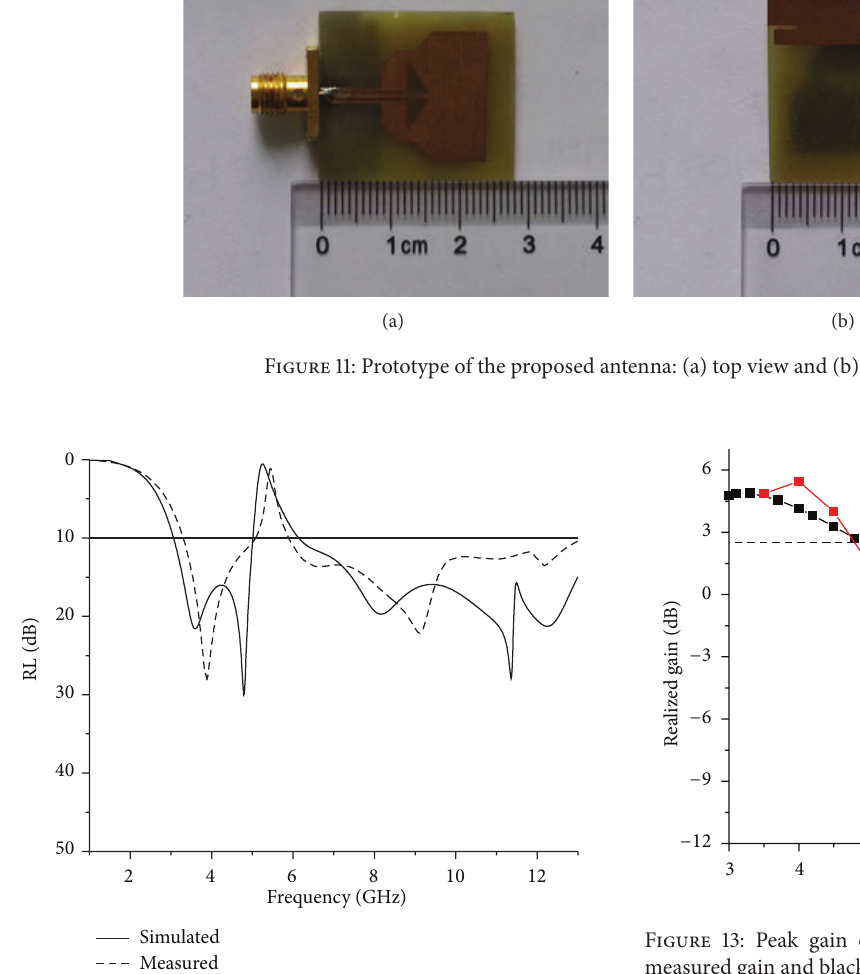
Figure 12: Comparison between the measured and simulated return losses.